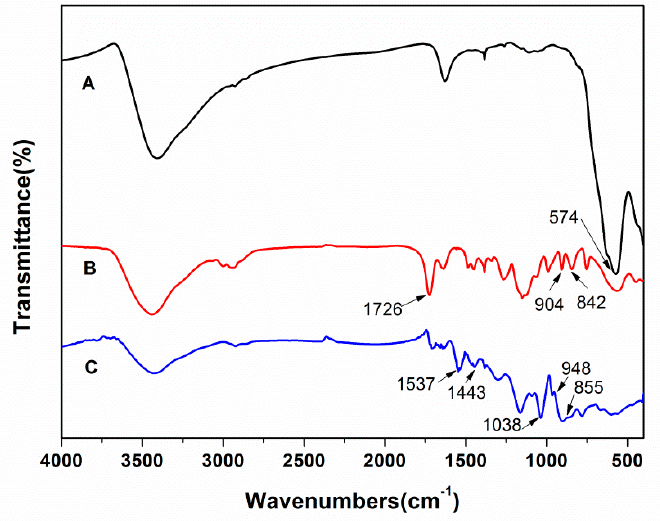
Figure 2. FT-IR spectrum of Fe 3 O 4 ( A ), magnetic PGMA ( B ), and magnetic PGMA-g-PPy ( C ).